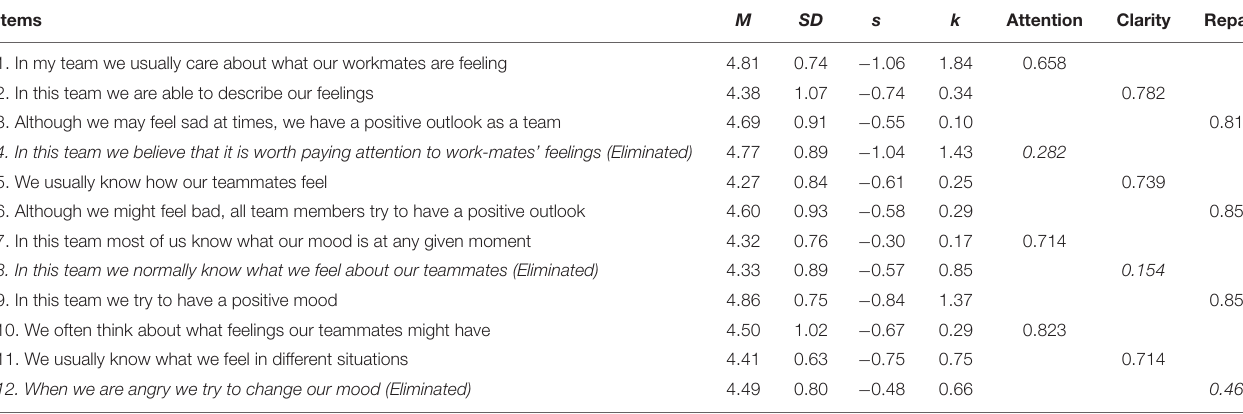
TABLE 1 | Initial items included in the T-TMMS, their descriptive statistics, and factor loadings. Items M